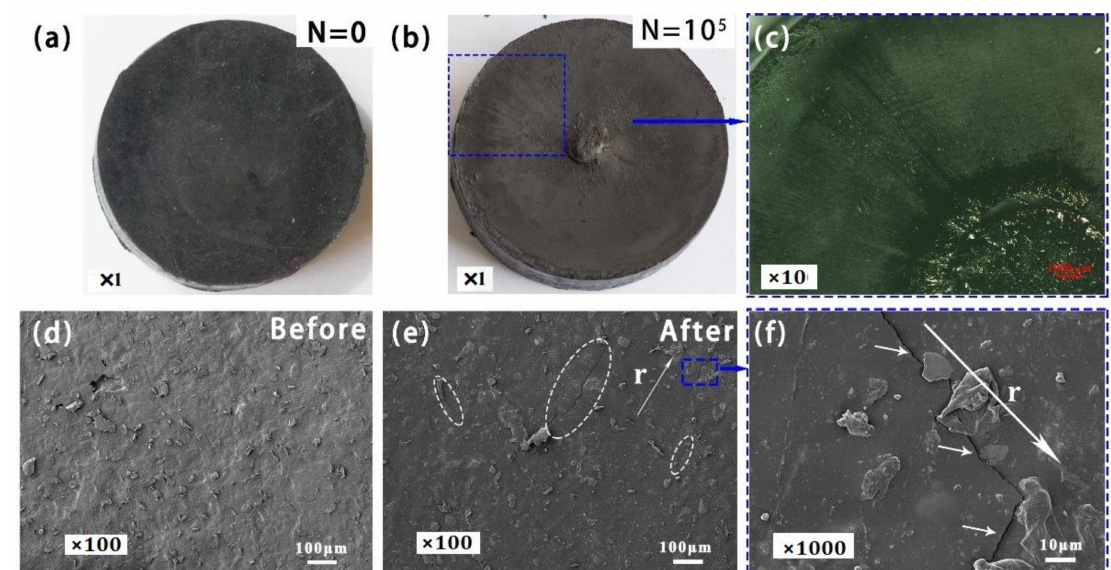
Figure 4. Photos and SEM images of top surface damages of filled SBR 3 before and after 10 4 compressive test cycles. ( a , b ) The photo images before and after fatigue test. ( c ) Zoomed-in photo of damaged top surface. ( d ) SEM images before fatigue test. ( e ) SEM images after fatigue test. Many cracks can be observed on the top surface. ( f ) Magnified SEM images of the